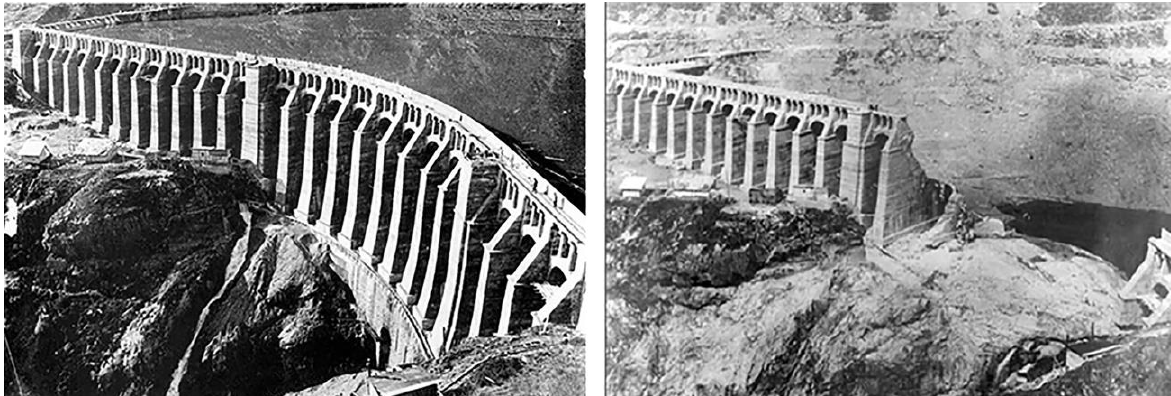
Figure 8. Gleno Dam before and after the failure [26].